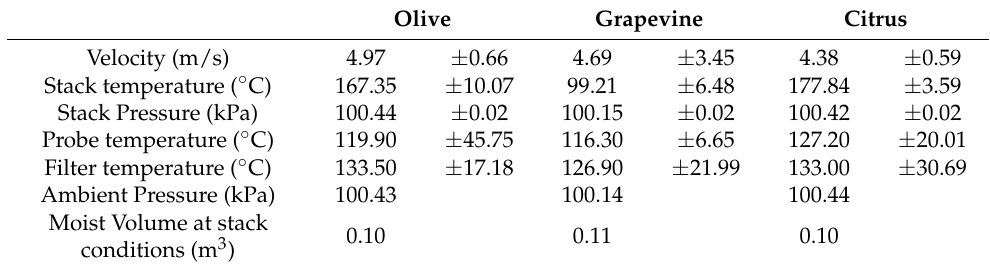
Table 1. Sampling conditions at